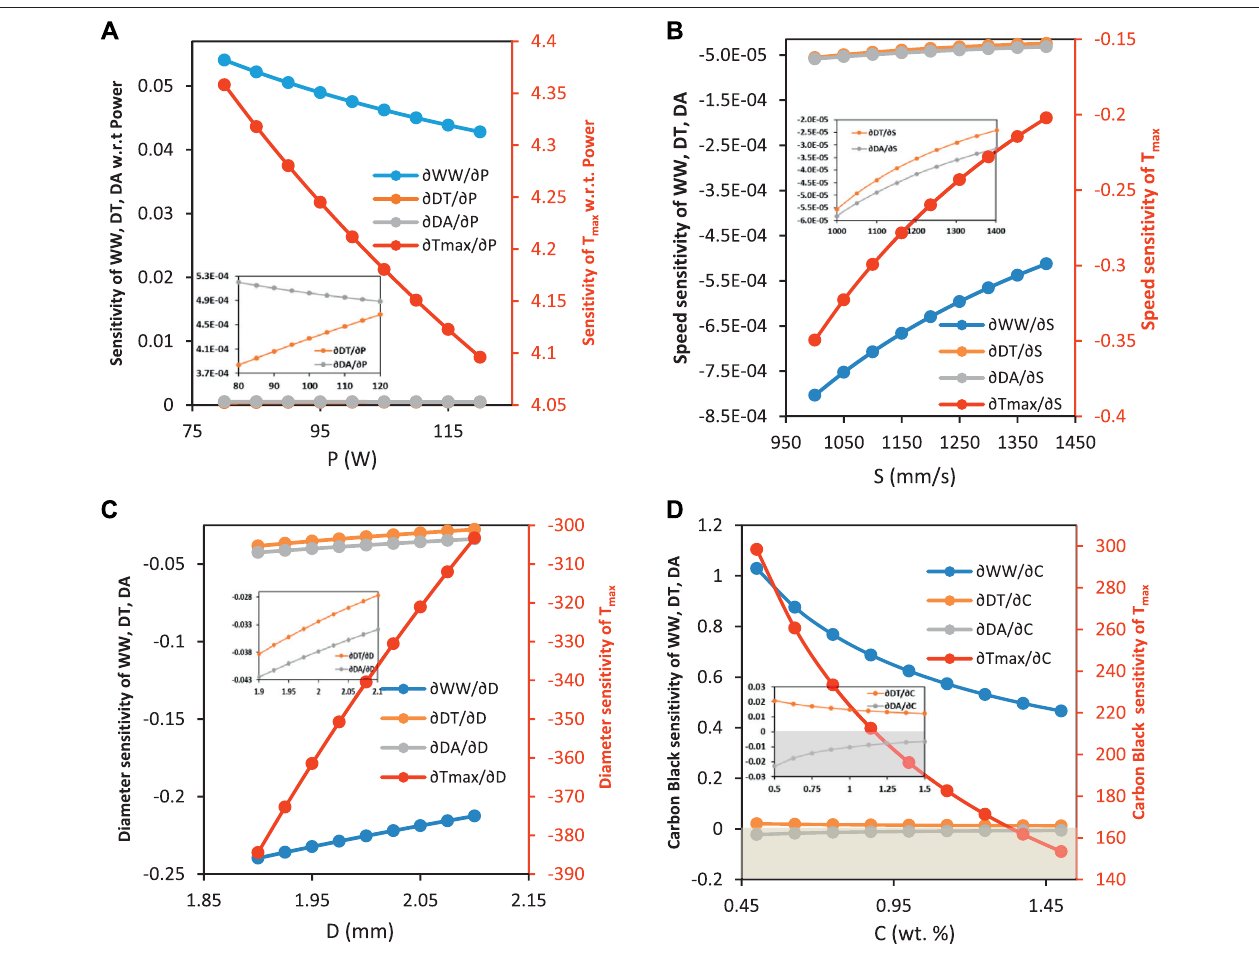
FIGURE8| Sensitivityanalysisresultsfor (A) power(constantparameters:weldingspeed (cid:1) 1,200 mm/s,beamdiameter (cid:1) 2 mm,andcarbonblackcontent1 wt% (B) speed(constantparameters:power (cid:1) 100 W,beamdiameter (cid:1) 2 mm,andcarbonblackcontent1 wt% (C) beamdiameter(constantparameters:power (cid:1) 100 W,welding speed (cid:1) 1,200 mm/s,andcarbonblackcontent1 wt% (D) carbonblack(constantparameters:power (cid:1) 100 W,weldingspeed (cid:1) 1,200 mm/s,andbeamdiameter (cid:1) 2 mm.